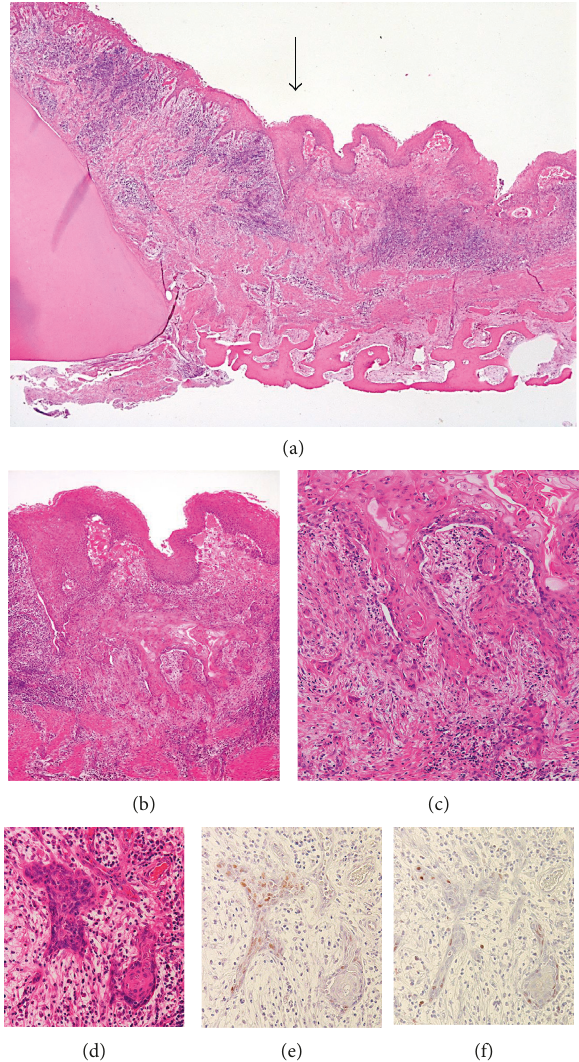
Figure 5: Microscopic features of the surgical specimen. (a) Invasion of atypical epithelium (black arrow). (b) Invasive squamous epithelium irregularly migrating from the epithelial cyst lining similar to SCC. (c) High-power magnification. (d) Invasive nests, (e) p53, and (f) Ki-67 (HE and IHC; original magnification: × 12.5 (a), × 40 (b), × 100 (c), and × 200 (d), (e), and